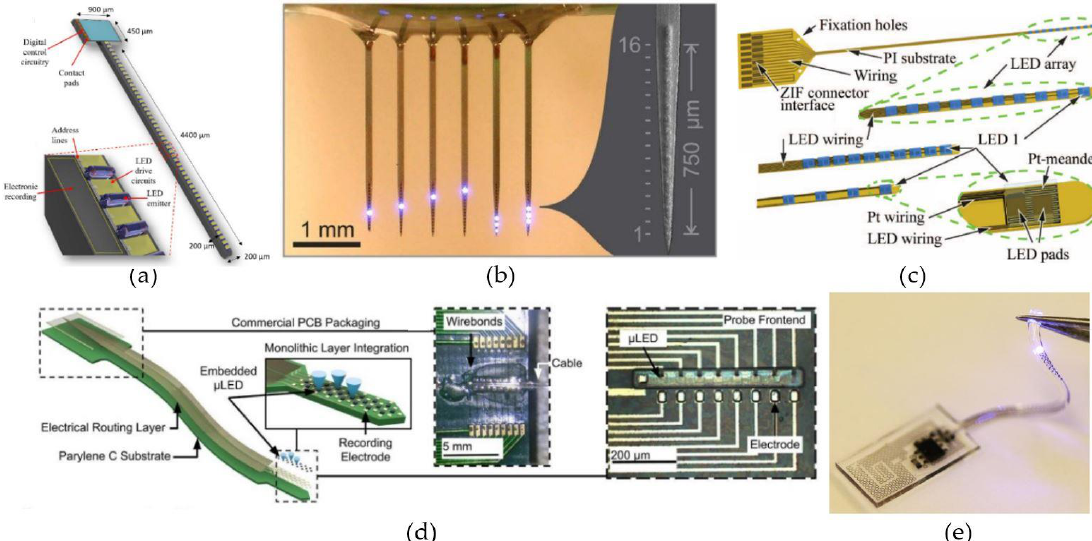
Figure 2. µ LED-based neural probes. ( a ) Scalable architecture of the CMOS optrode with 49 LEDs deposited along the 4400- µ m-long shaft. Reproduced with permission from [114]; published by IEEE, 2018. ( b ) Multi-shank probe with 96 individually addressable µ LEDs distributed along 6 shanks. Reproduced with permission from [112]; published by Nature, 2016. ( c ) Optical cochlear implant constructed by individually flip-chip bonding ten LEDs on top of a 12- µ m-thin, highly flexible, polyimide-based probe. Reproduced with permission from [115]; published by IEEE, 2016. ( d ) High density, flexible optrode with embedded gallium nitride µ LEDs. Reproduced with permission from [116]; published by Frontiers, 2019. ( e ) Fully implantable, wireless optogenetics system, with a PDMS encapsulated LED, for optogenetic modulation of the spinal cord and peripheral nervous system. Reproduced with permission from [117]; published by Nature, 2015.